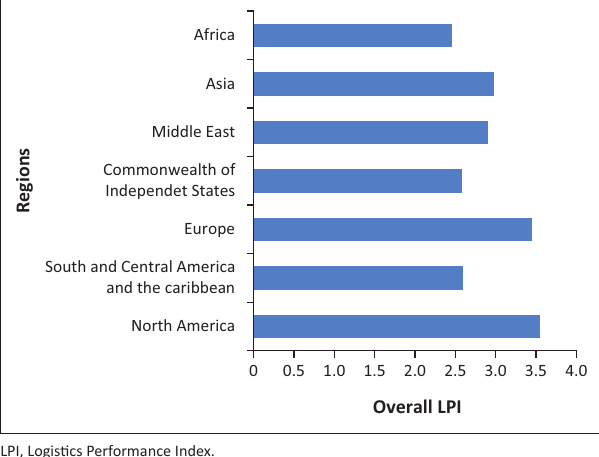
FIGURE 2: World regions’ overall Logistics Performance Index in